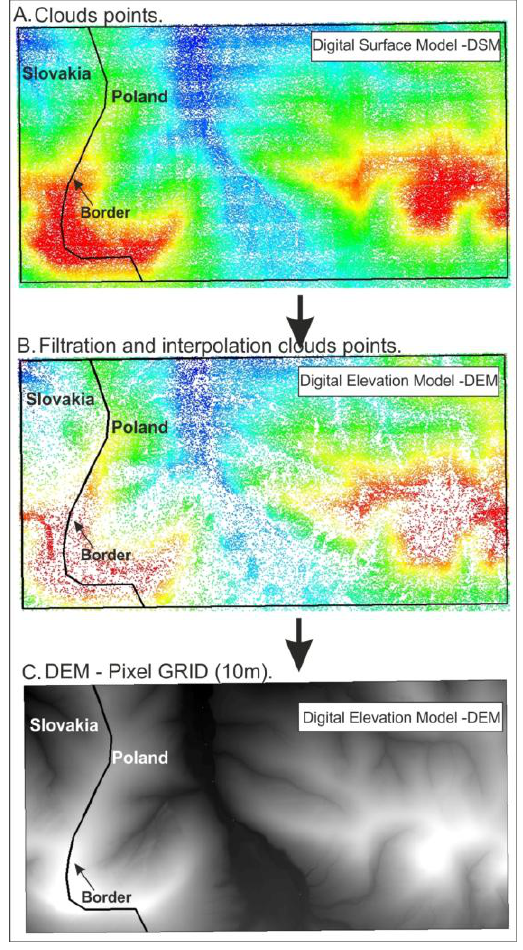
Fig.2. Steps of generating DEM elevation data derived from airborne laser